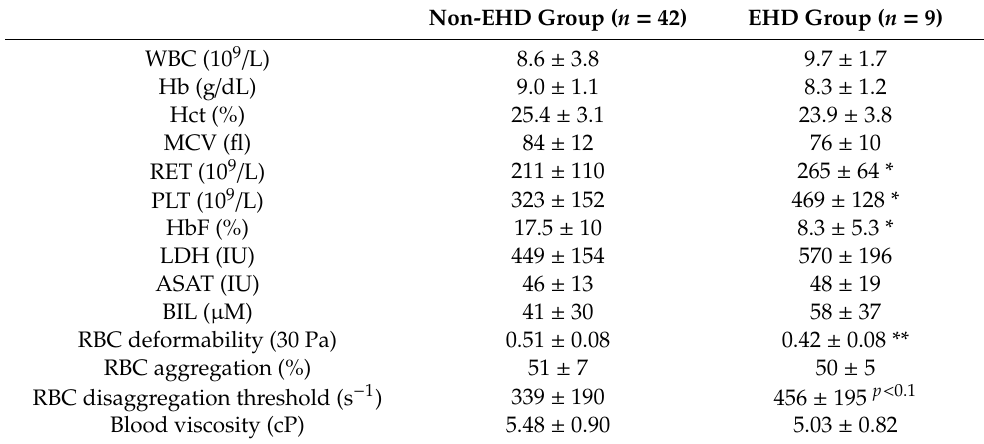
Table 4. Biological parameters of the patients according to exercise-related hemoglobin